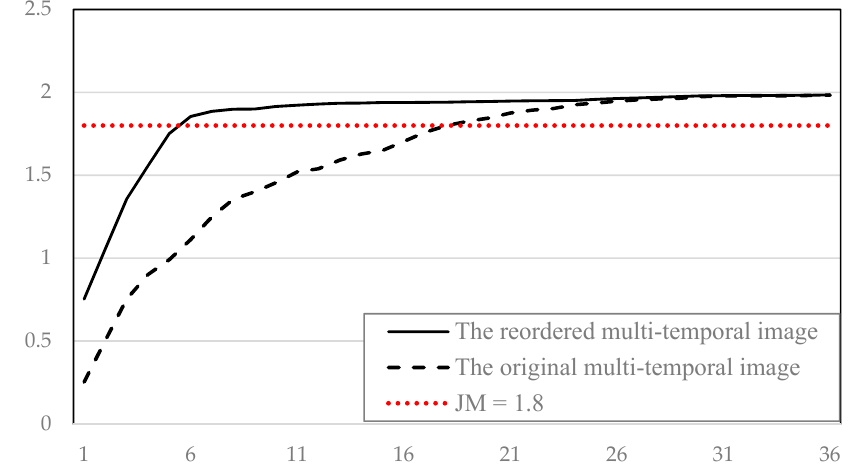
Figure 6. Relationship between the number of temporal images and the J–M distance.